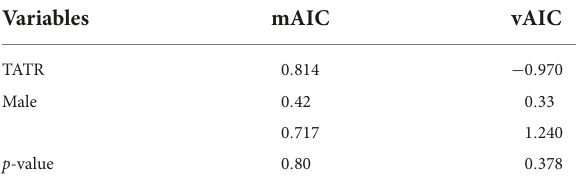
significant difference, indicating the biased nature of dispersal. TABLE 5 Test for the differences between sexes in the mean (mAIC) and variance (vAIC) of the corrected assignment index with significant values ( P <